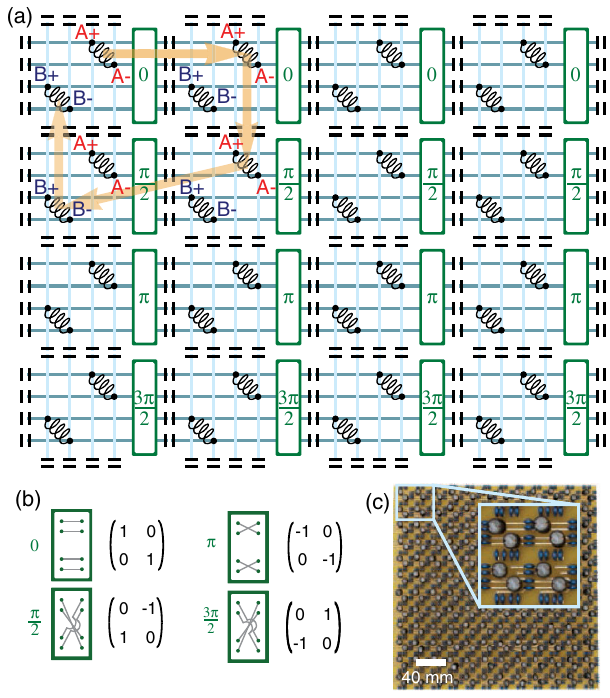
FIG. 1. (a) Circuit topological insulator schematic. The periodic structure is formed by on-site inductors and coupling capacitors (black) that are connected via a latticework of wires (light and dark blue lines). At each lattice site, the two inductors “ A ” and “ B ” correspond to right and left circularly polarized spins. When a photon traverses a single plaquette (indicated by orange), it accumulates a Berry phase of π = 2 . The phase is induced by braiding [indicated by the green boxes and specified in (b)] of the capacitive couplings. (b) Structure of the coupling elements between lattice sites. Each row shows one of the four rotation angles implemented by the capacitive coupling in the circuit. The rotation angle (left column) is induced by connecting inductors as shown (middle column). The corresponding rotation matrices (right column) indicate the inductors being coupled, as well as the signs of the couplings. (c) Photograph of circuit topological insulator. The inductors (black cylinders) are coupled via the capacitors (blue); circuit topology is determined by the trace layout on the printed circuit board (yellow). Inset: Zoom-in view of a single plaquette consisting of four adjacent lattice